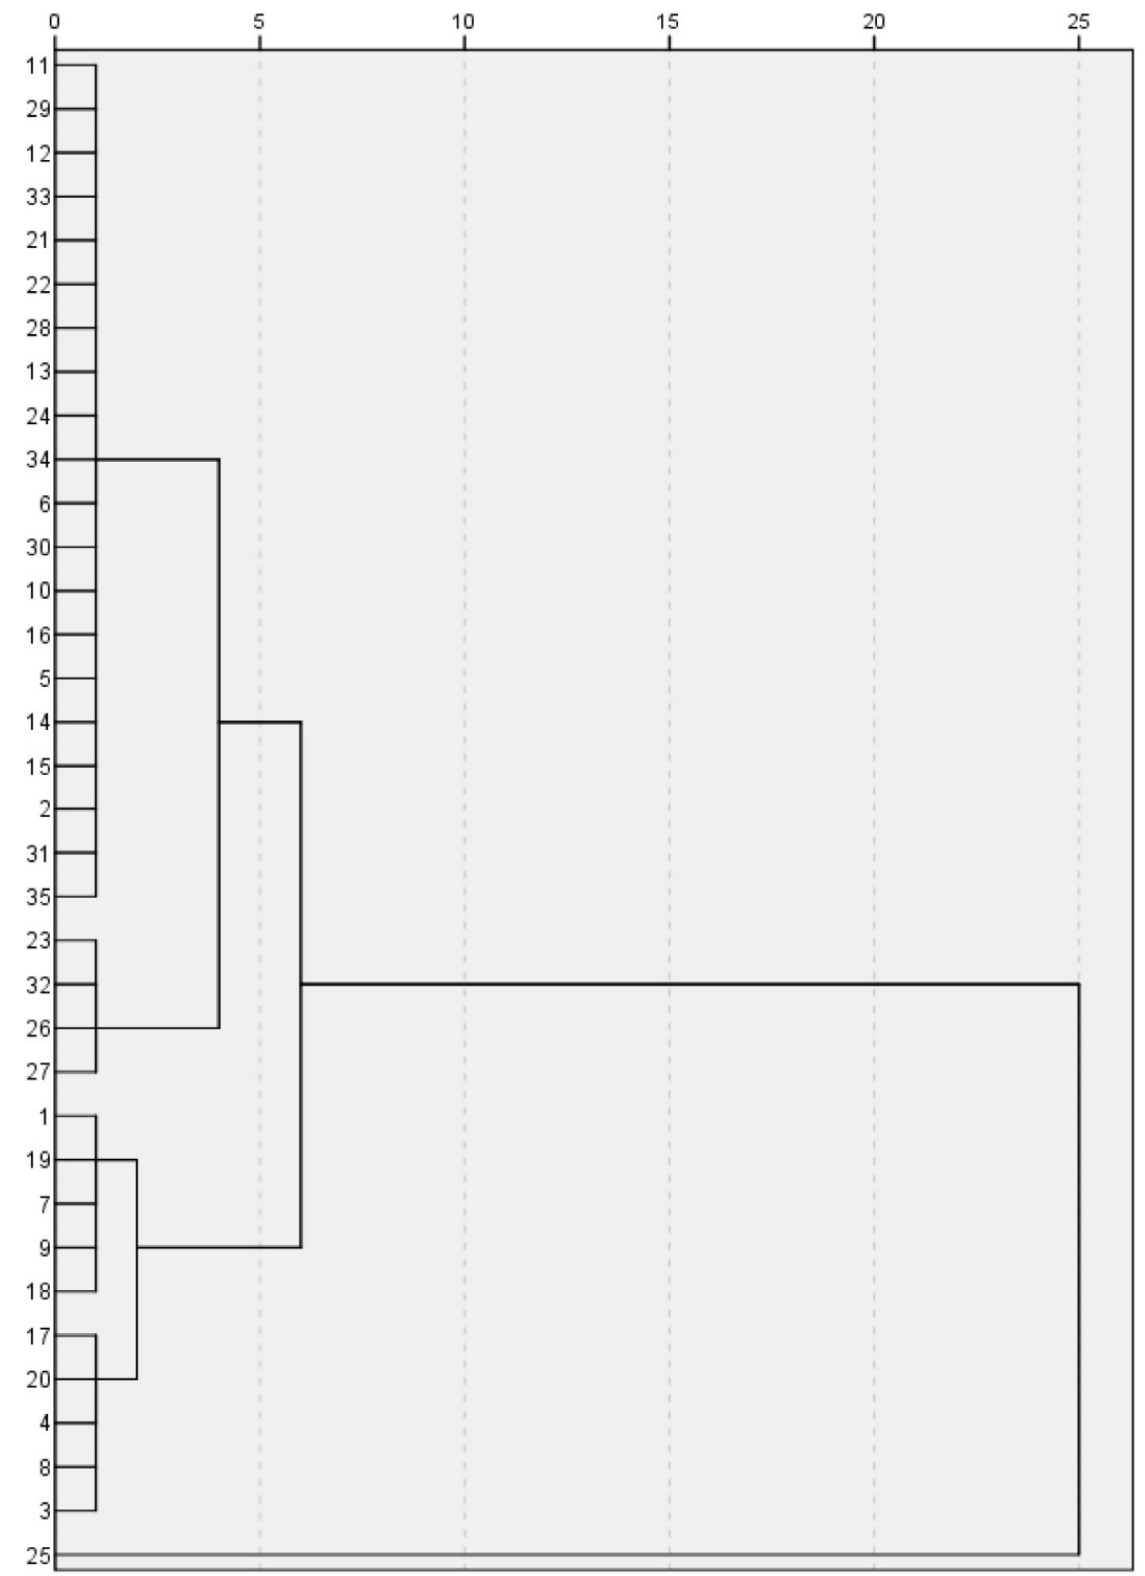
Figure 5. R-mode HCA of HMs in seawater samples.